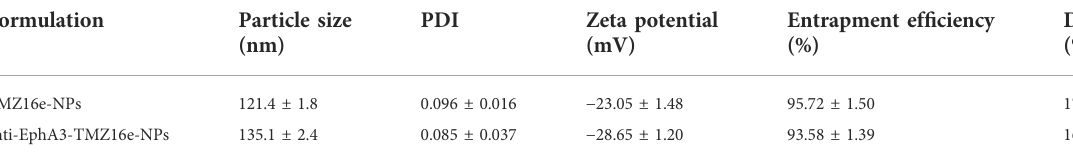
TABLE 1 Characterization of TMZ16e-NPs and anti-EphA3-TMZ16e-NPs (n = 3). Formulation